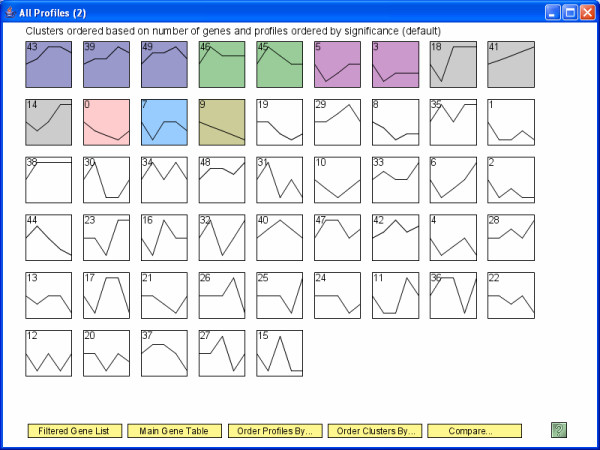
Example model profiles overview interface. The example data is drawn from an experiment measuring the response of gastric epithelial cells infected with the vacA-mutant strain of the pathogen Helicobacter pylori [3]. The data was sampled at five time points 0 h, .5 h, 3 h, 6 h, and 12 h. The data set was filtered to contain only the 2989 genes with no missing data (though STEM can handle missing data without filtering, see Additional file 1) that exhibited a .8 log base two fold increase or decrease for at least one time point. The number in the top left-hand corner of a profile box is the profile ID number. The colored profiles had a statistically significant number of genes assigned. Non-white profiles of the same color represent profiles grouped into a single cluster. By clicking on one of the buttons along the bottom of the window, a dialog window appears by which the profiles can be reordered by various criteria. Another button displays a table of all genes passing filter and the profile to which they were assigned. Clicking on a profile box brings up detailed information about the profile (Figure 5).